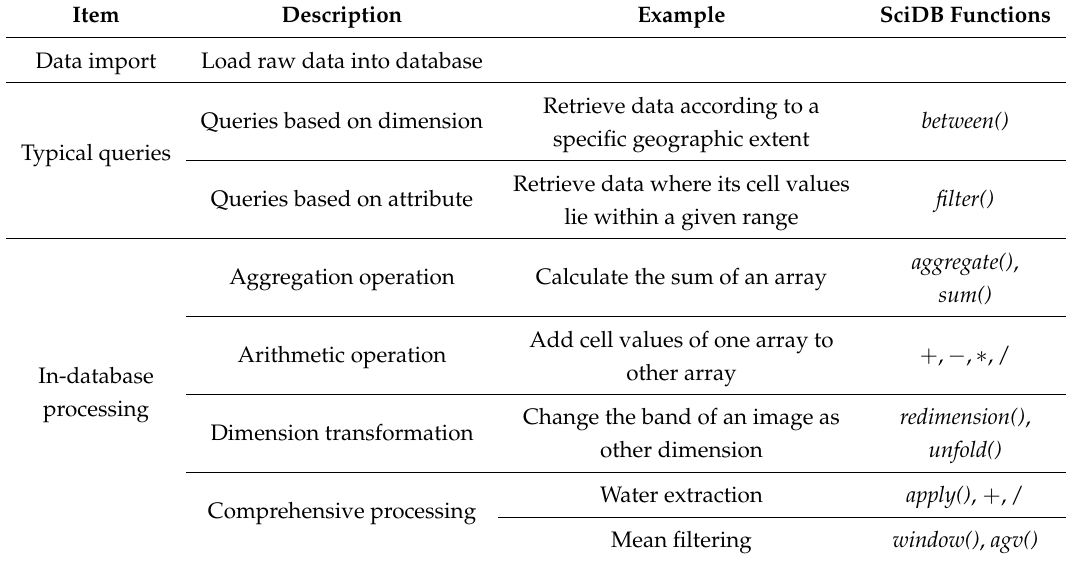
Table 4. Performance evaluation items.